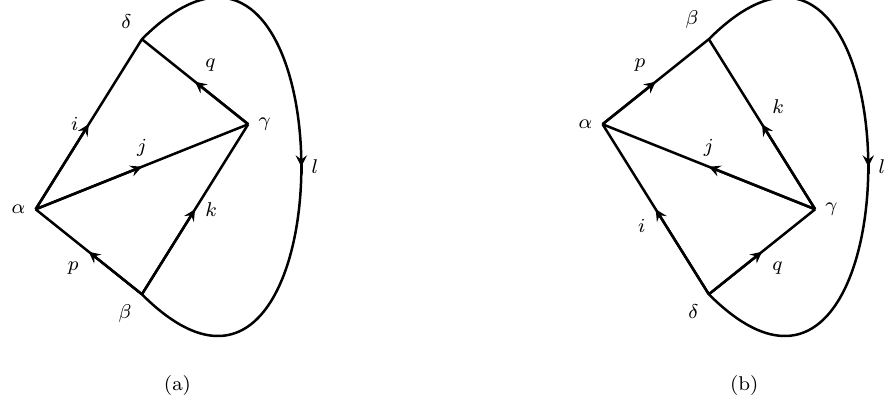
Figure 11 . Graph attached to a tetrahedron: (a) positive chirality and (b) negative